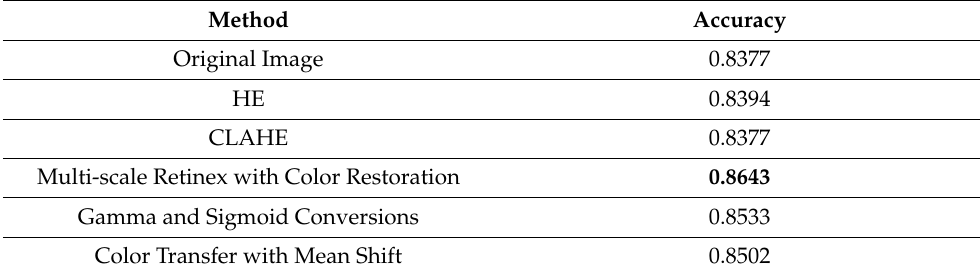
Table 5. Accuracy of 3 color transfer methods in HP vs. combination of TA and SSA.